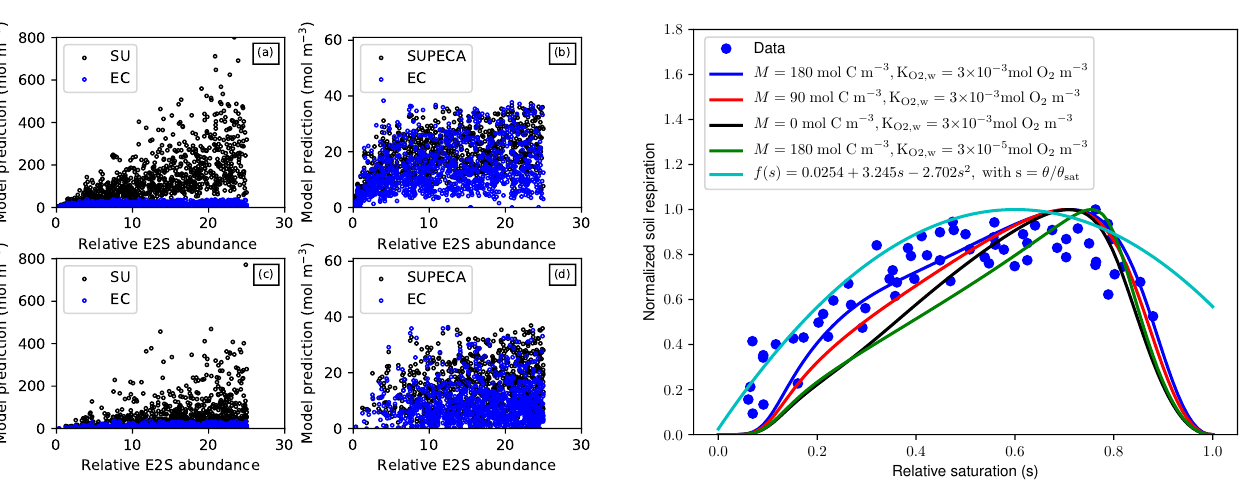
Figure 5. Comparison of predicted normalized soil moisture re- sponse functions to that derived from incubation data from Fran- zluebbers (1999). All response functions are normalized with their respective peak respiration. The R 2 coefficients of determination for the different response function curves from top to bottom are, respectively, 0.82, 0.81, 0.77, 0.71, and 0.84. Note that the curve of f (s) has been normalized to set its maximum value at 1, making it slightly above the majority of the data